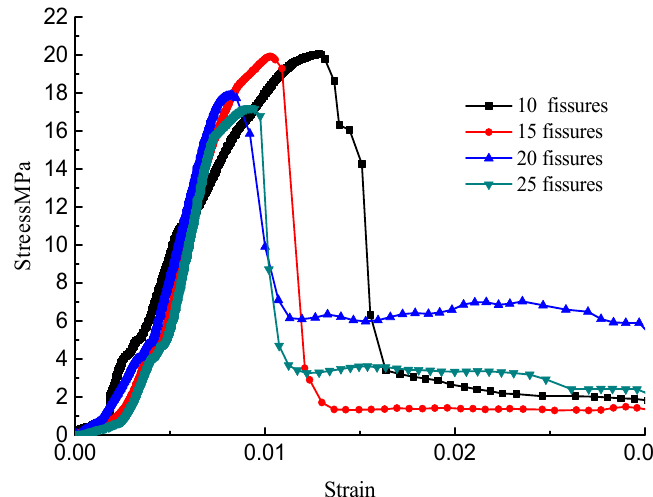
Figure 13. Stress–strain curves with a crack angle of 90°.